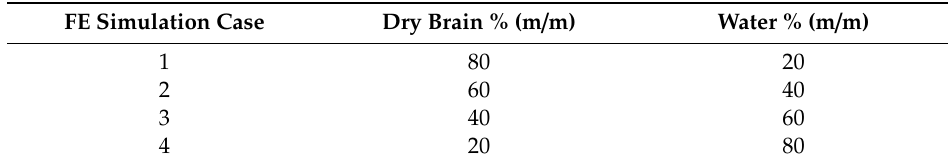
Table 2. Overview of the finite element (FE) simulation cases for the micromechanics of dry brain and water content variation.